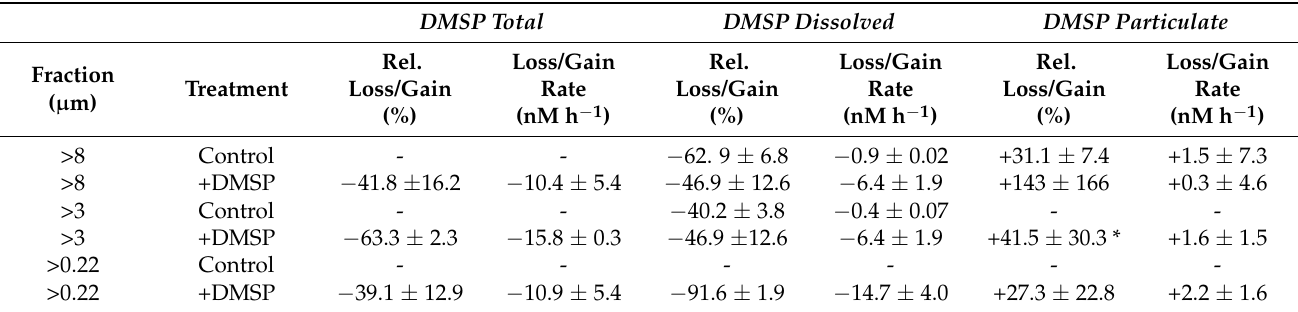
Table 4. Relative loss/gain and rate of DMSP for each size fraction and treatment for DMSPt, DMSPd and DMSPp. This is a numerical summary of data presented in Figure 4. Relative loss/gain was calculated as % of DMSP lost/gained relative to its initial concentration (i.e., ∆ Concentration/initial concentration × 100). Loss/gain rates were determined as the change in concentration over time and obtained from the slope of the linear regression. Samples with no significant ( p > 0.05) DMSP loss or gain between initial and final time have been omitted and are indicated with a dash. Samples that lose DMSP over time are indicated with negative values and samples that gain DMSP over time are indicated with positive values. Data show mean +/ − SD and n = 3 *. DMSP